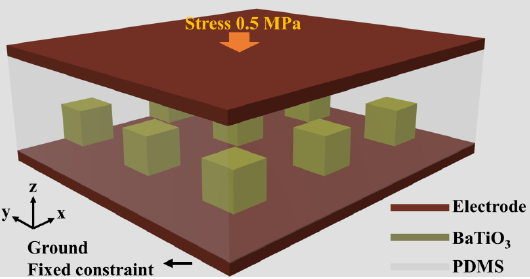
Figure 1. Schematic illustration of the BaTiO 3 /polydimethylsiloxane (PDMS) composite piezoelectric nanogenerator